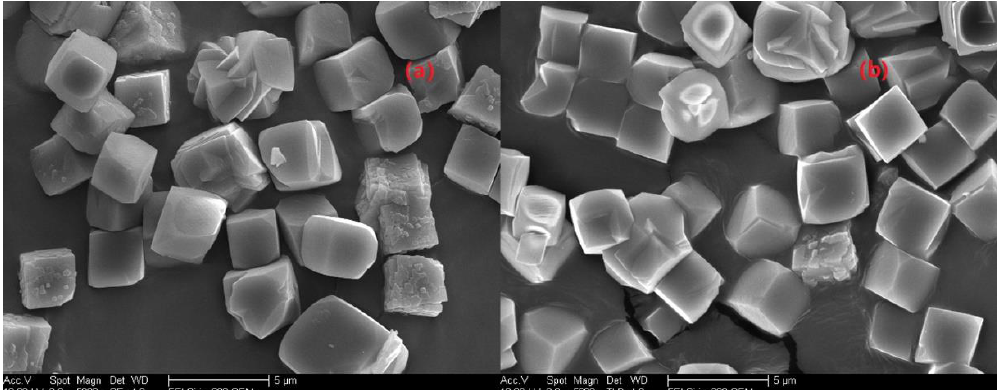
Figure 6. SEM images of S-13 ( a ) and S-17 ( b ).